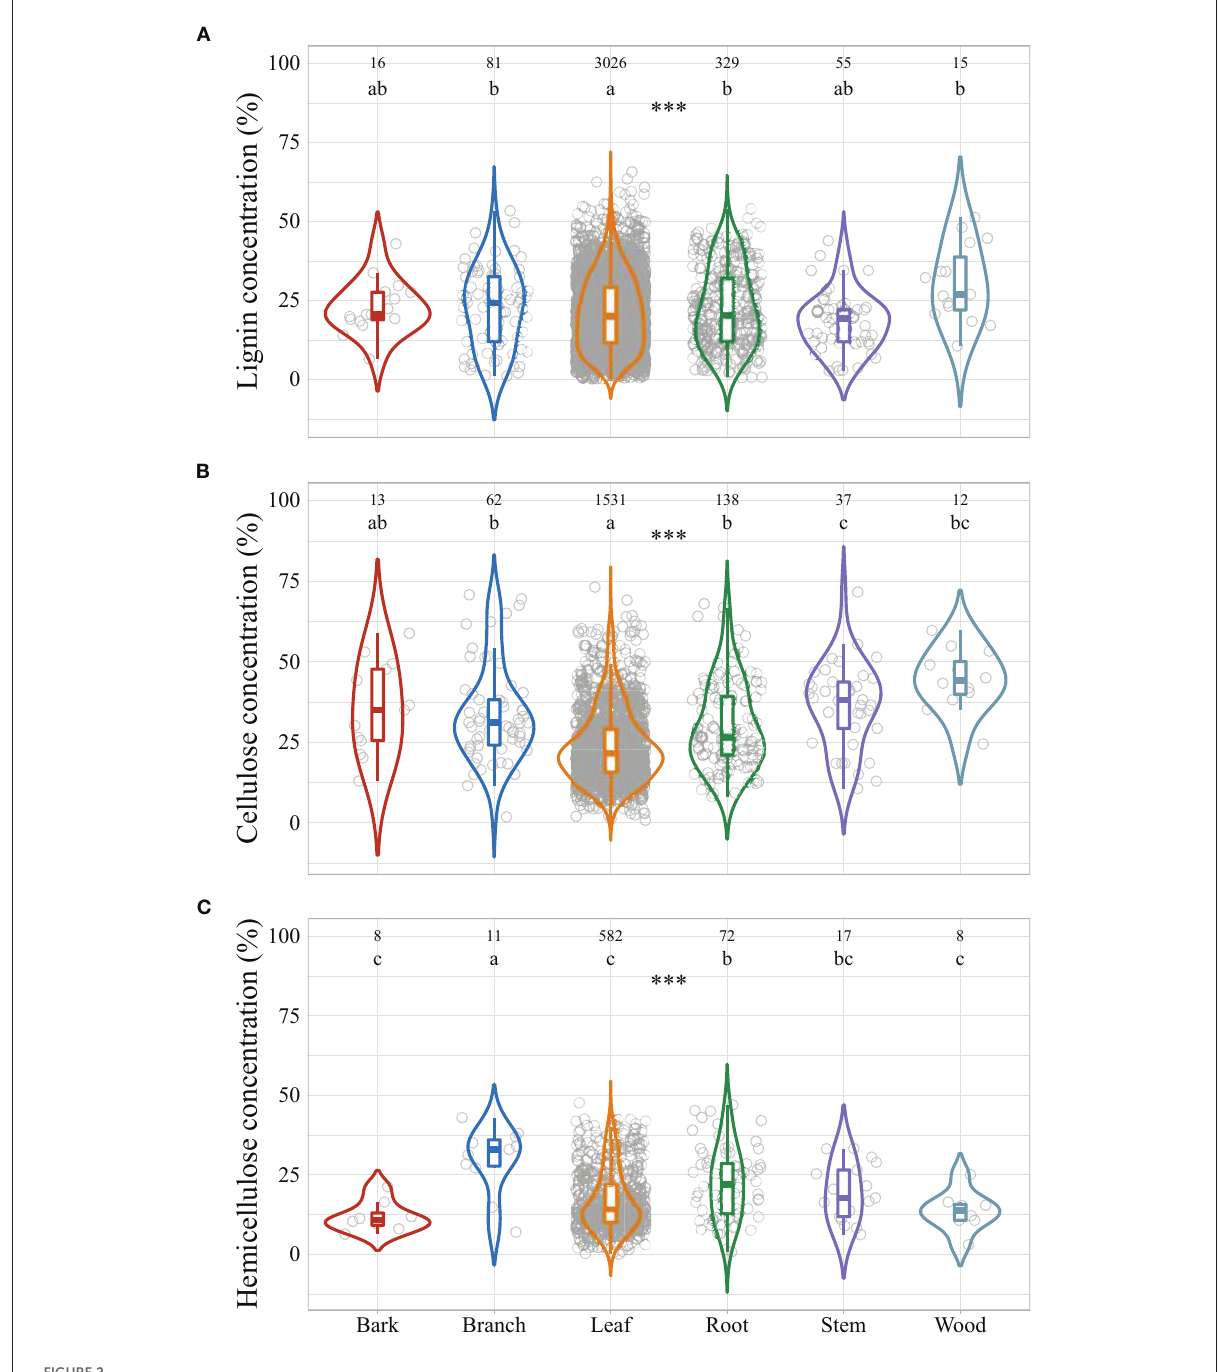
FIGURE2 Violin plots of the concentrations of plant litter lignin (A) , cellulose (B) , and hemicellulose (C) grouped by litter types. Asterisks indicate significant effects of litter type, and different letters indicate significant differences among different litter types at α = 0.05. *** p <